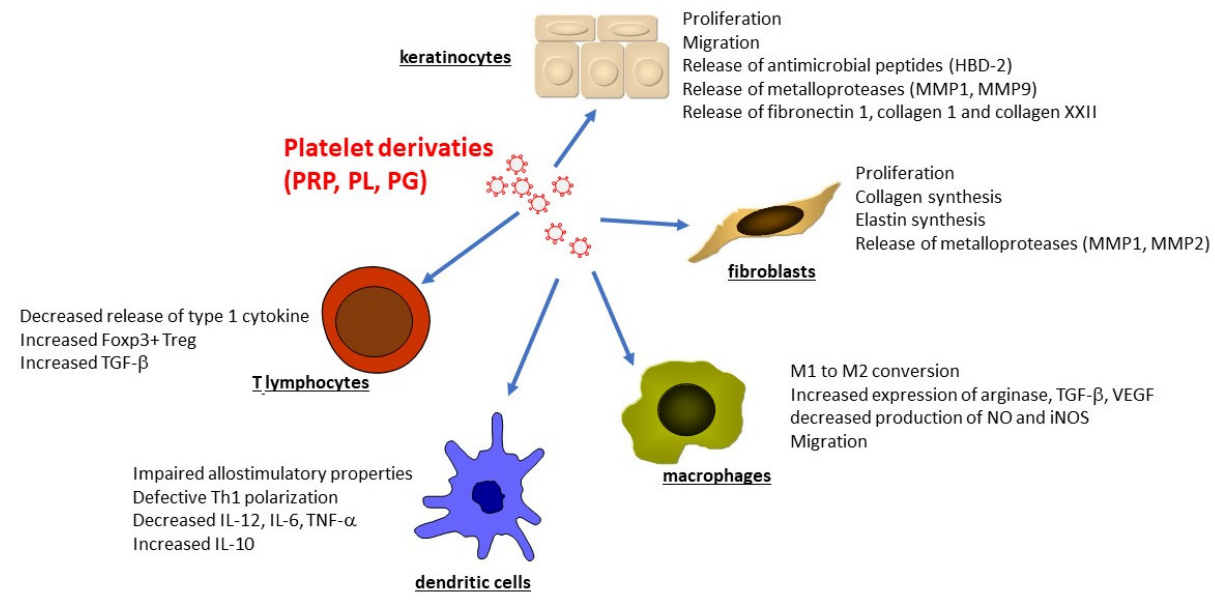
Figure 2. Effect of Platelet derivatives on human cells involved in Wound Healing. Fibroblasts are equally affected by platelet-derived biomaterial. Exposure to PRP has been reported to increase the expression of type I collagen, elastin, MMP-1, and MMP- 2 [121], as well as fibroblast proliferation [119,122,123]. Finally, Thrombin-activated PRP affects neo-angiogenesis, as demonstrated by the induction of the proliferation of HUVEC and endothelial cells